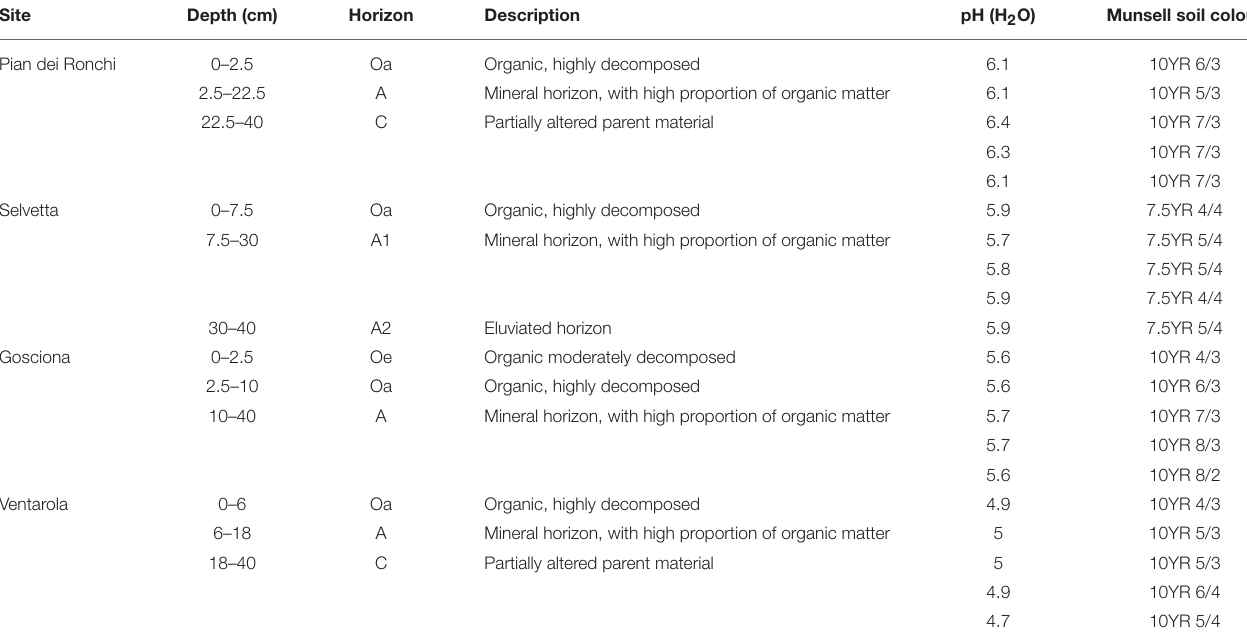
TABLE 1 | Description of the soil horizons from the selected profiles as reported by Molinari and Montanari (2016, p. 33).